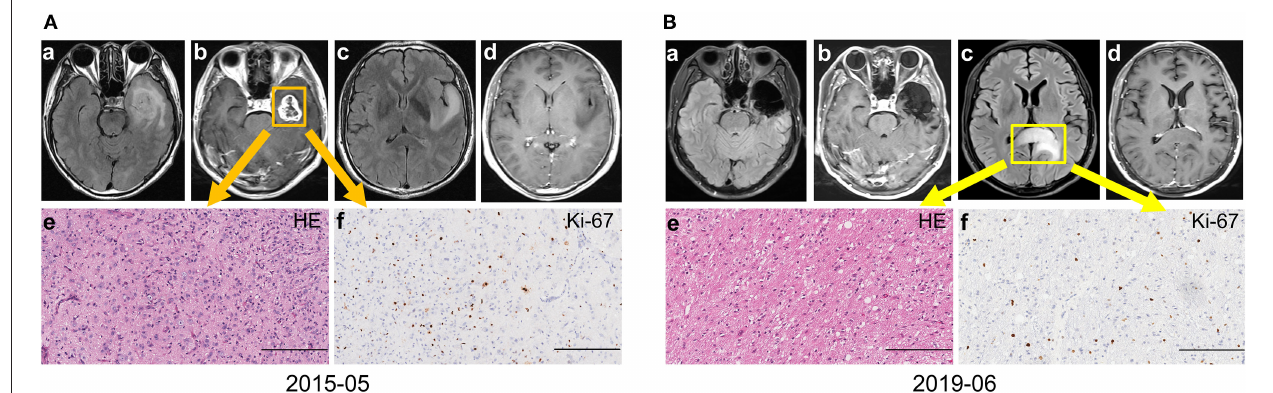
FIGURE 2 | A representative case for the discordant subgroup with distant intracranial metastasis. (A) The patient presented unbearable headache with contrast-enhancing (CE) lesion on left temporal (a–d). Craniotomy was performed and the tumor was totally removed. The final diagnose was primary GBM, IDH wild-type, WHO grade 4 (e–f). (B) Forty-nine months after the operation, a non-CE lesion on the splenium of the corpus callosum with space-occupying effect (a–d) was suspected tumor progression. The final pathology diagnosis was GBM, IDH wild-type, WHO grade 4 (e–f) based on the WHO 2021 brain tumor classification system (Bars, 200 µ m). GBM, glioblastoma; IDH, isocitrate